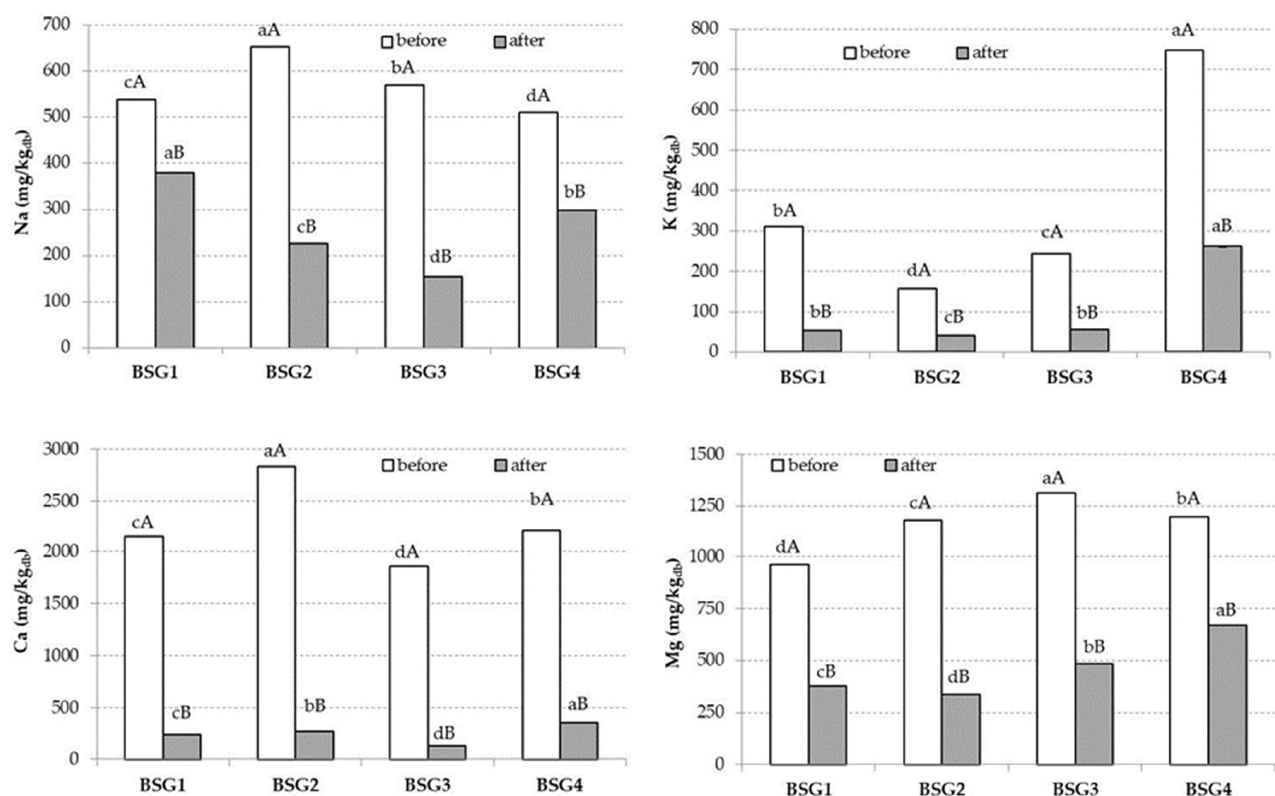
Figure 2. Mean values and standard deviations (error bars) of the macro-mineral (Na, K, Ca, and Mg) contents in four different brewers’ spent grain (BSG) samples. For each mineral, small letters indicate homogeneous groups established by the ANOVA ( p < 0.05) by comparing BSGs before and after in vitro digestion. For each mineral, capital letters indicate homogeneous groups established by the ANOVA ( p < 0.05) by comparing samples before and after in vitro digestion for each BSG sample. Note: db, dry weight.